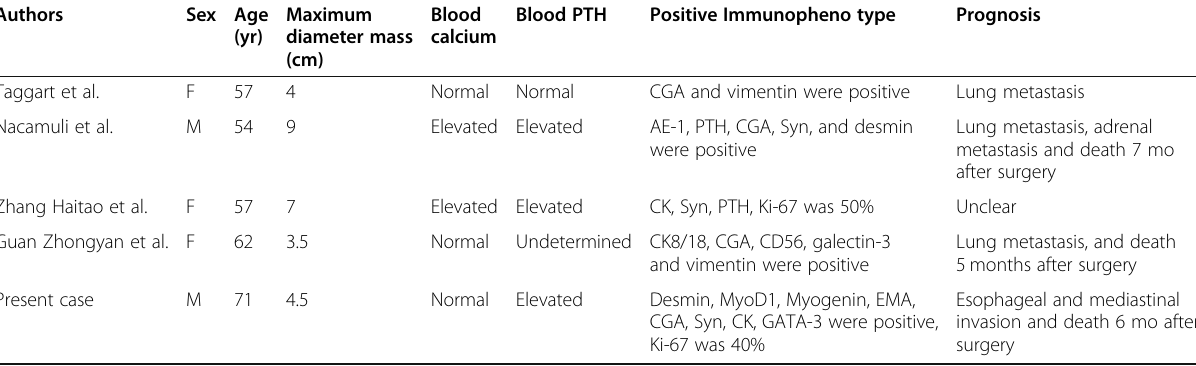
F represents female, M represents